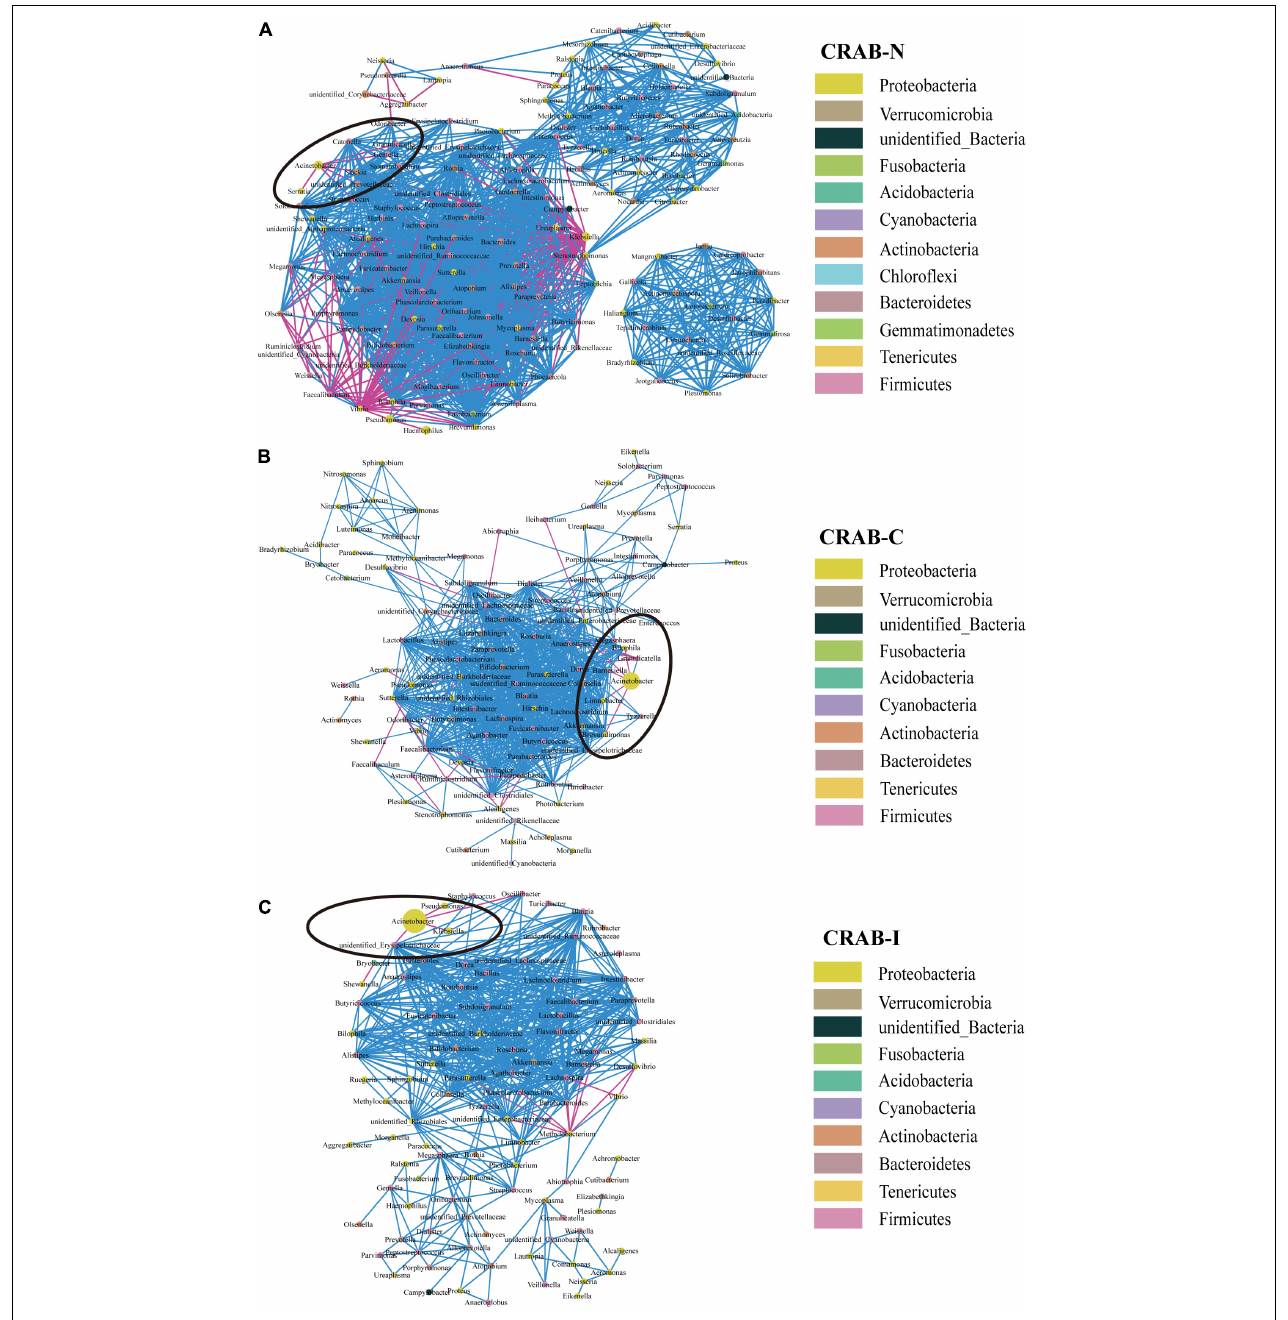
FIGURE 4 | Co-occurring network of microbial communities in LRT samples from CRAB-N (A) , CRAB-C (B) , and CRAB-I patients (C) . A co-occurring network containing strong ( ρ > 0.6) and significant (FDR-adjusted P < 0.05) correlations was represented. Each node represents a genusa and the nodes are colored by phylum. The size of each node is proportional to the number of connections. The thickness of each edge is proportional to the ρ . Light blue lines represent negative correlations, and red lines represent positive